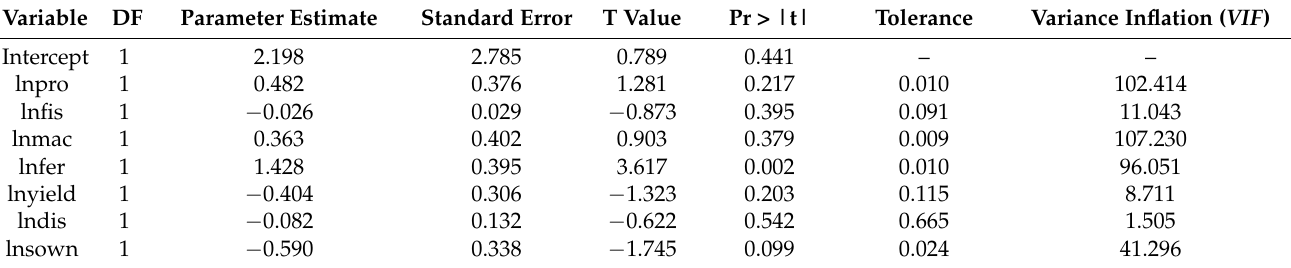
Table 3. Parameter Estimates.